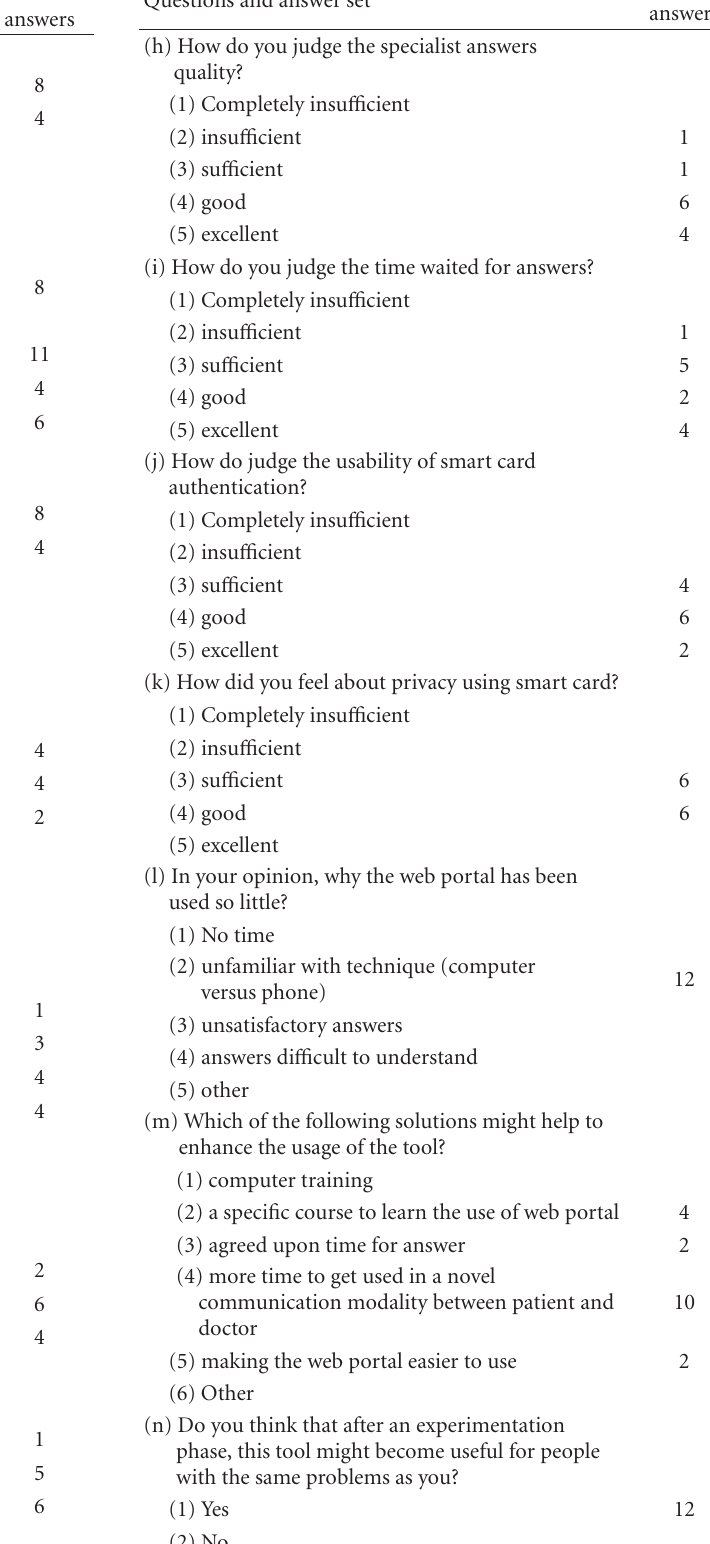
Table 1: The questionnaire and subject